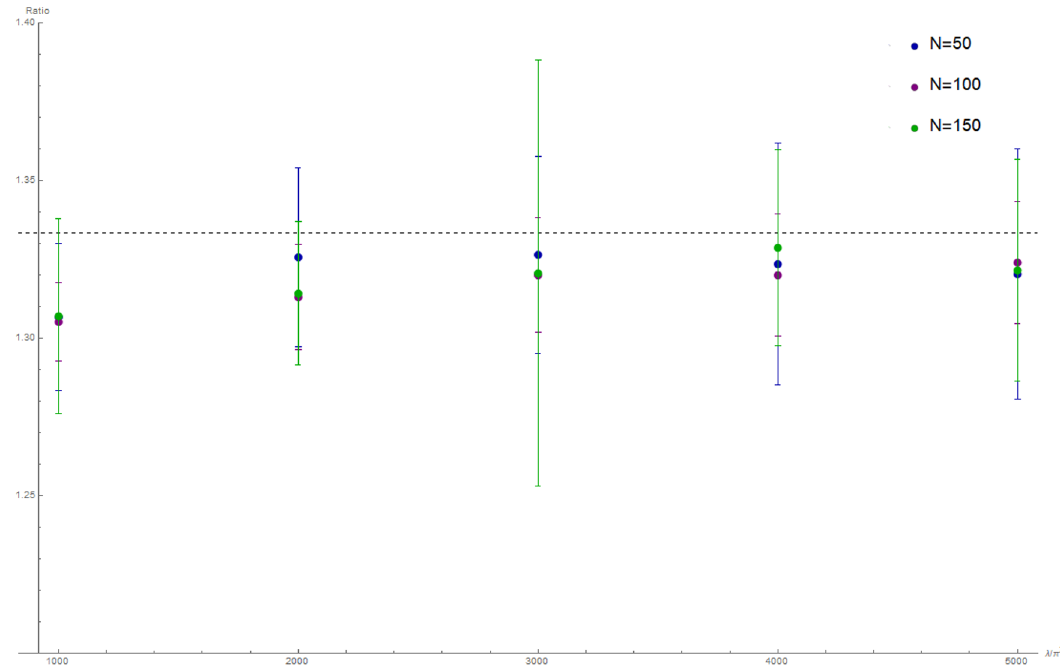
Figure 6 : Ratio between the 2-point function (5.17) for n = 3 in the circular quiver with M = 3 and those found in the circular quiver with M = 2 , in the range 1000 π 2 ≤ λ ≤ 5000 π 2 and for N = 50 , 100 , 150 . The expected ratio is 4 / 3